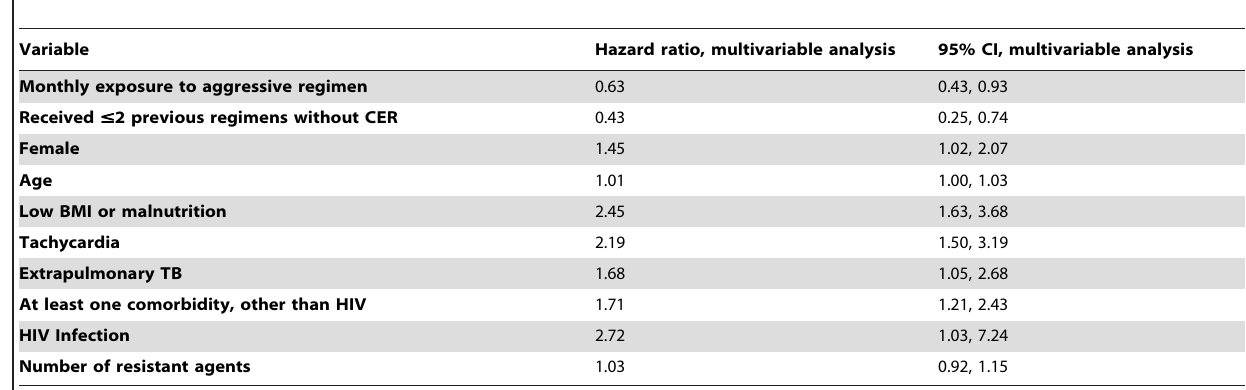
Table 4. Multivariable, time-varying Cox proportional hazards analysis of aggressive regimen and time to death.